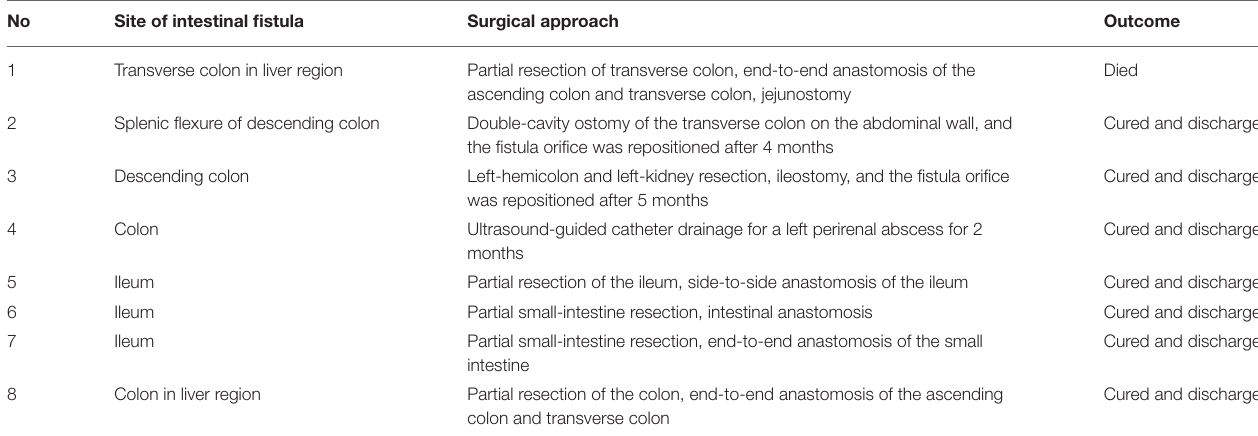
TABLE 5 | Surgical approaches and